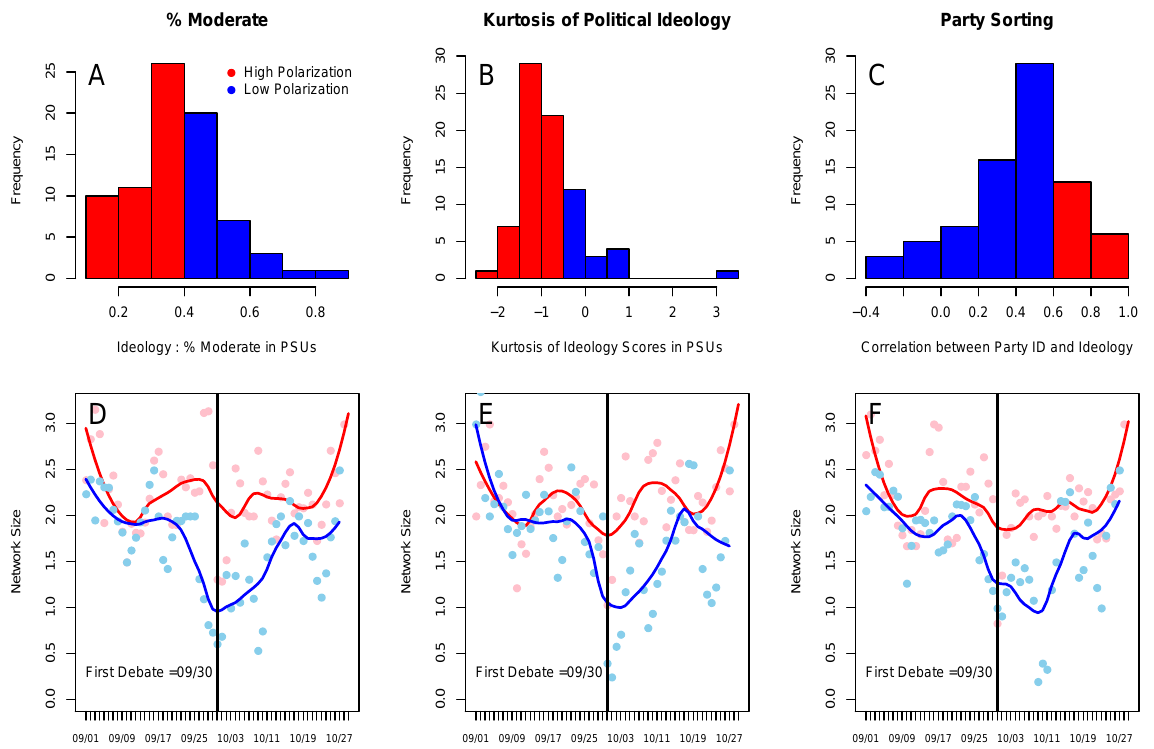
Figure 5: Priming and spatial political polarization in 2004. Note: We measure political polarization in each PSU ( sampcode ) in three different ways and plot their distribution. Panel A reports the proportion of moderate respondents, panel B reports the kurtosis of political ideology, and the correlation coefficient between party identification and political ideology is reported in panel C. We dichotomize each measure based on its mean value and plot the mean network size per day as differently colored circles by level of polarization: low (blue) and high (red). As in Figure 4, the smoothed means for network size are plotted as sky blue or pink circles—depending on the level of political polarization—with the loess curves